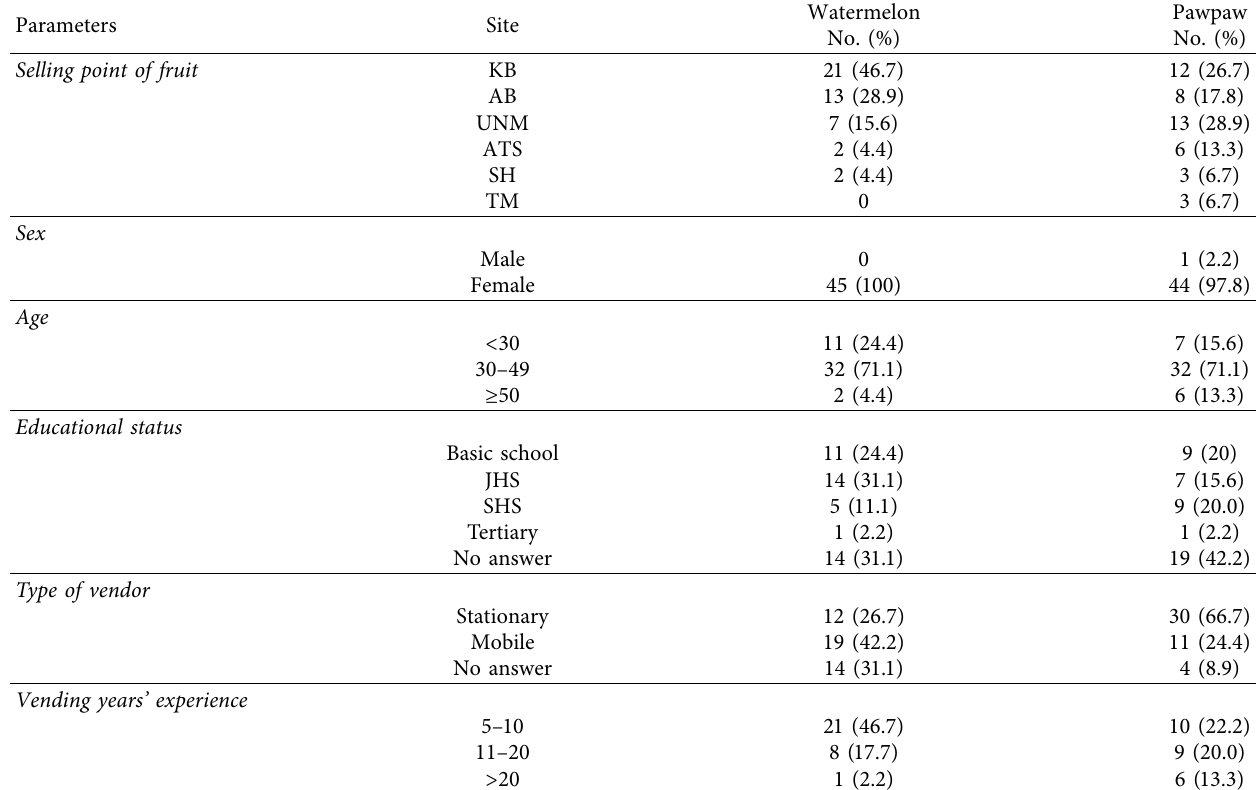
Table 1: Demographic characteristics of the fruit